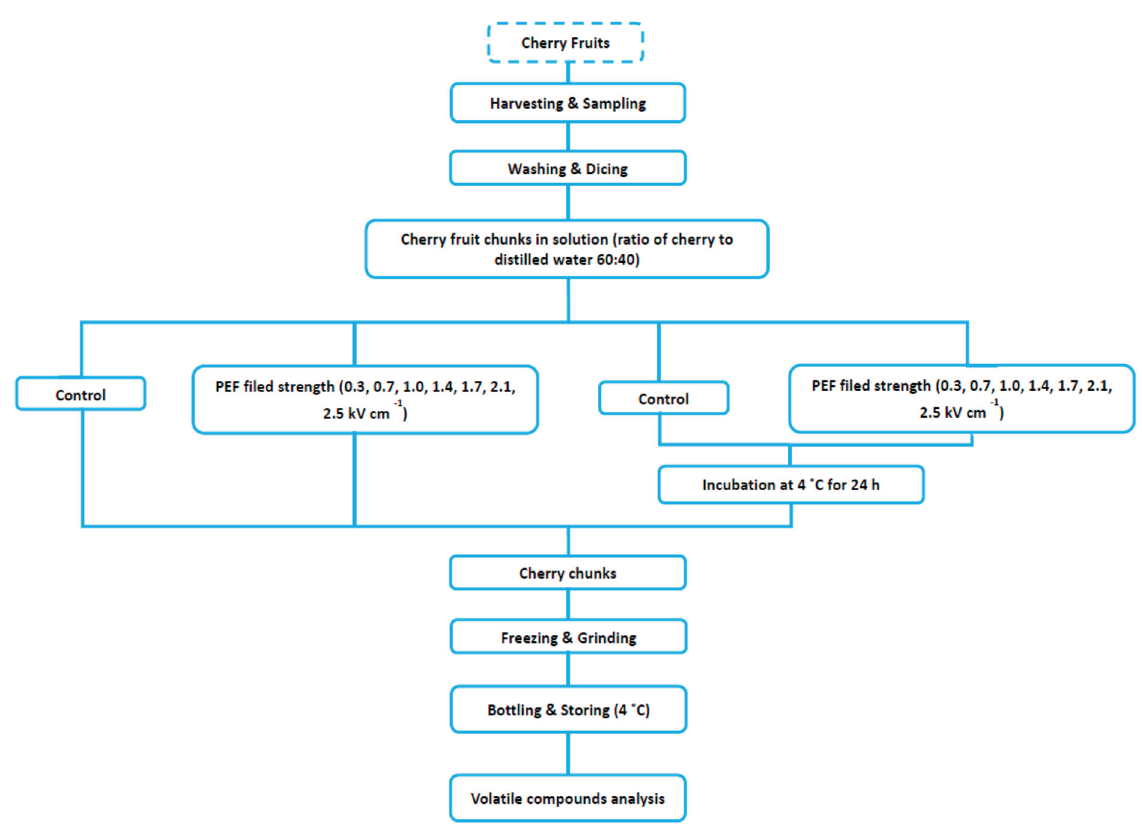
Figure 1. Schematic representation of experimental